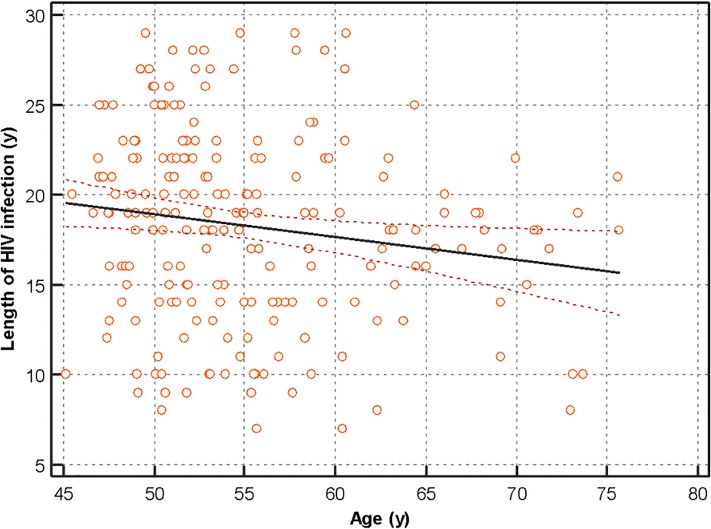
Correlation between length of HIV infection and patient´s age.